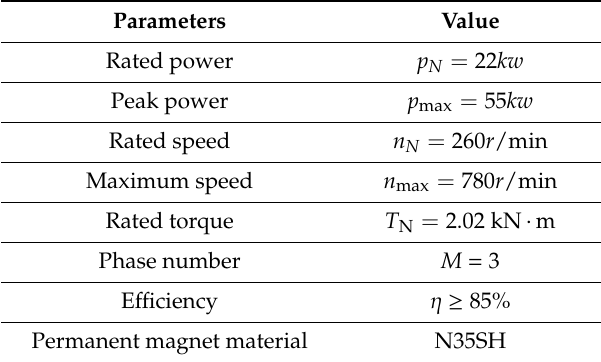
Table 2. Design requirements of the brushless DC